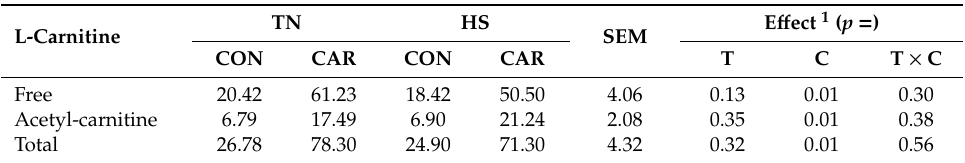
Table 2. Least squares means for L-carnitine fraction concentrations ( µ mol / L) in plasma of dairy goats under thermo-neutral (TN) or heat stress (HS) conditions. In each ambient temperature, goats were fed a control diet (CON) or supplemented with 1g L-carnitine